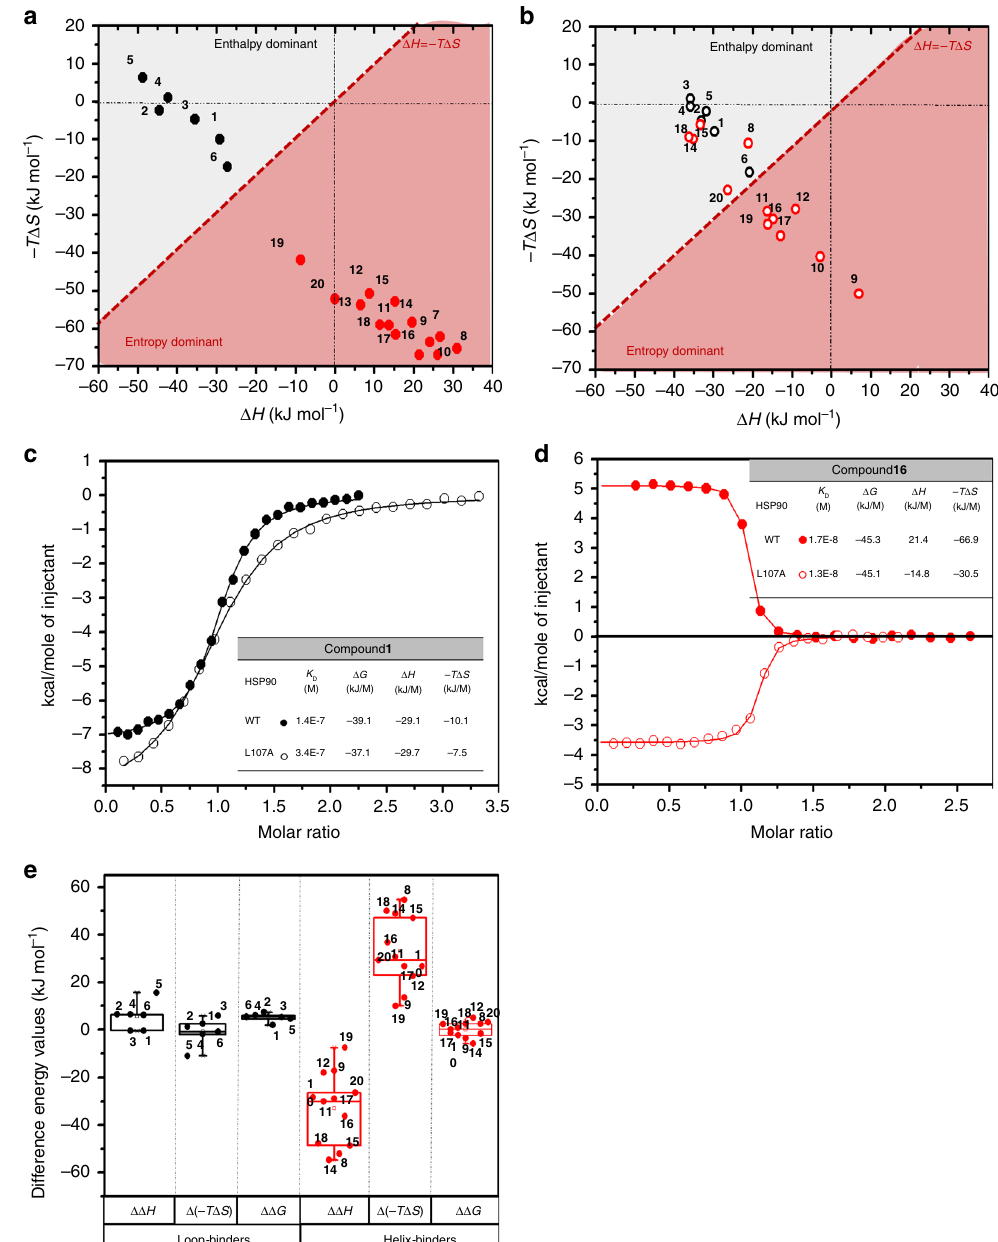
Fig. 3 Thermodynamic pro fi les of N-HSP90 inhibitors measured by ITC. The enthalpic and entropic components of the binding free energy are shown in a and b for for WT N-HSP90, and the L107A mutant, respectively. The dashed diagonal line ( Δ H = − T Δ S ) divides the plot into two main areas where the enthalpy (gray) or the entropy (red) dominate the binding free energy ( Δ G ). Compounds 1 – 6 are loop binders and are colored black and compounds 7 – 20 are helix-binders and are colored red. c , d Isothermal titration calorimetry fi tting curves for compounds 1 ( c ) and 16 ( d ) bound to WT N-HSP90 (full circles) and to the L107A mutant (open circles) with thermodynamic parameters shown in the respective tables. e Box plot showing the difference in the enthalpy ( ΔΔ H ), entropy ( Δ ( − T Δ S )) and binding free energy ( ΔΔ G ) for L07A relative to WT for loop- (colored black) and helix-binders (colored red). The boxes denote the 25th and 75th percentiles and the error bars the 5th and 95th